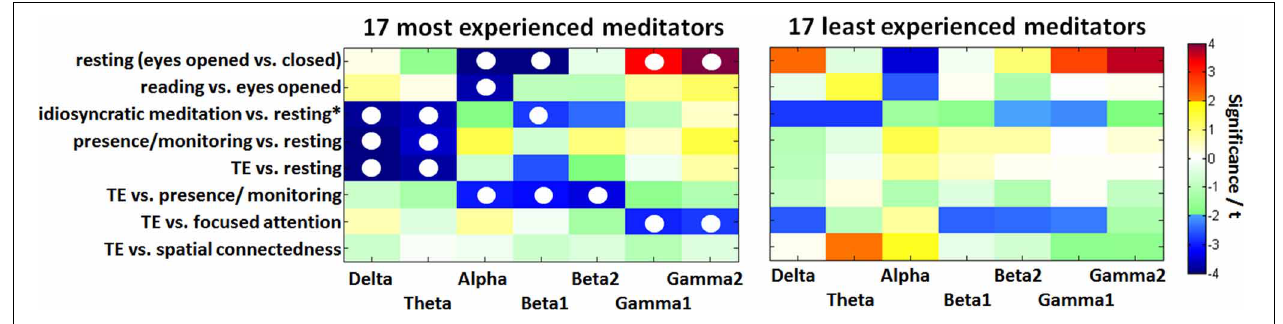
FIGURE 5 | Color-coded PSD differences shown as t -values resulting from the eight standard comparisons between psychophysiological states during the recording sessions for seven distinct frequency bands, averaged over the 17 most-experienced and the 17 least-experienced